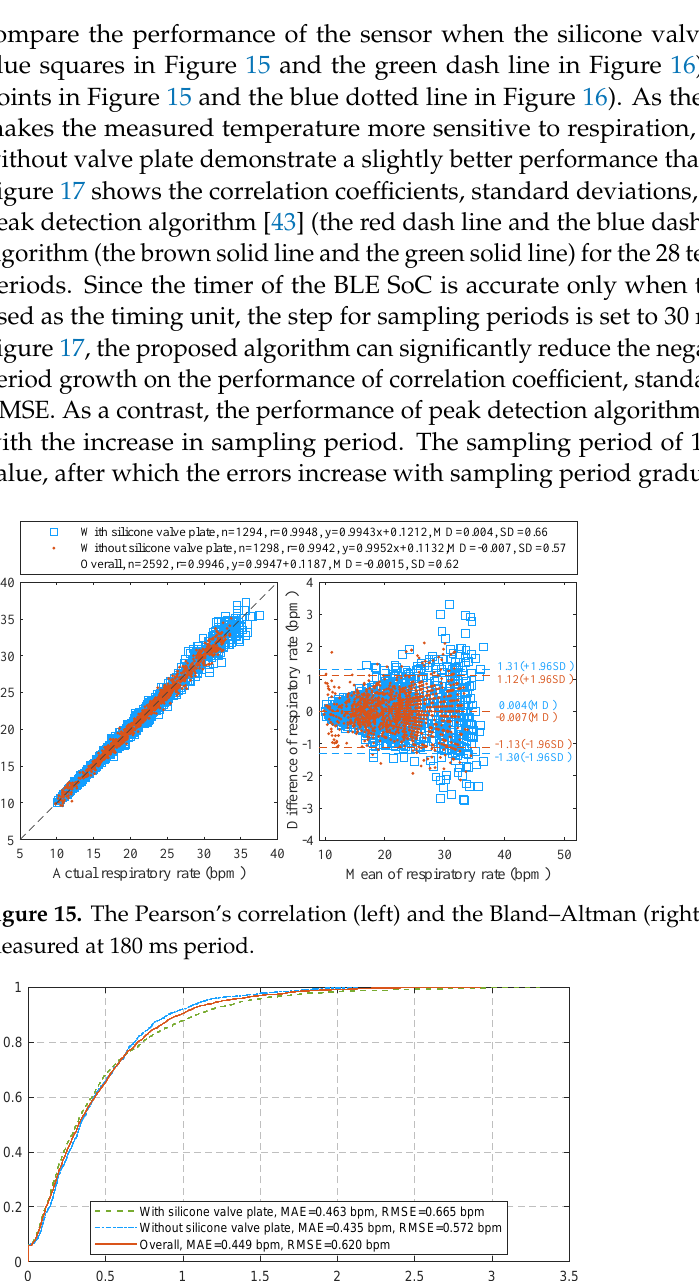
Figure 16. The CDF of respiratory rate estimation error at 180 ms sampling